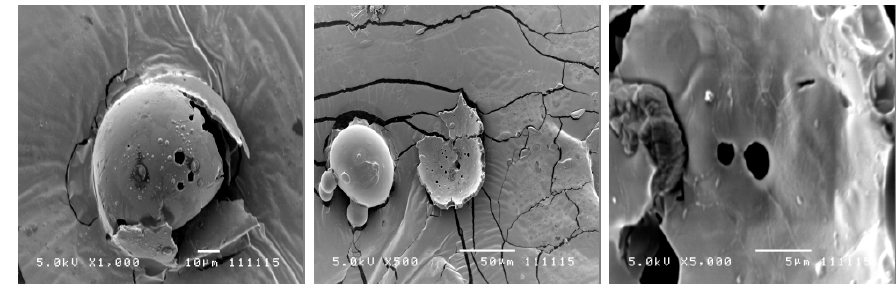
Figure 6. SEM images of degraded MC after 22 days of drug release.